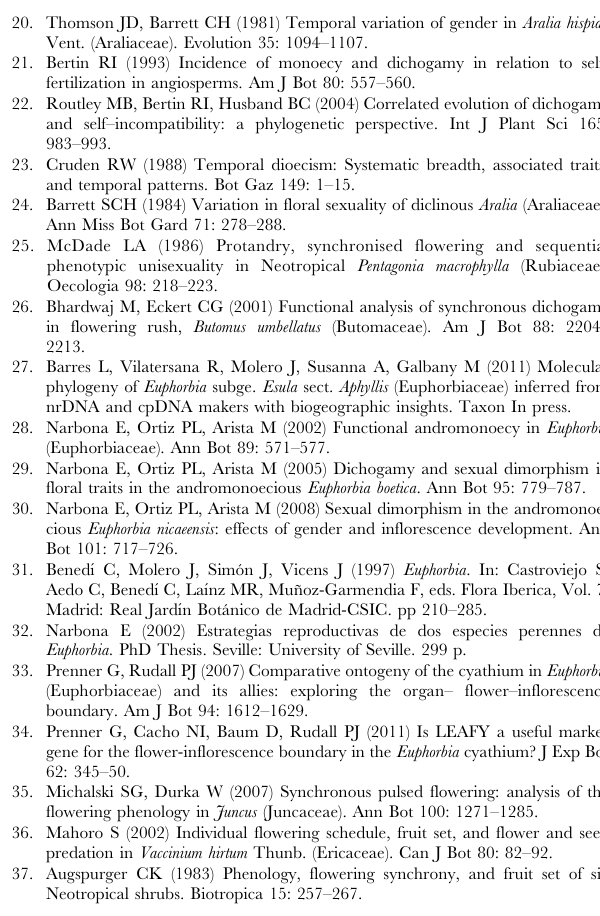
Figure S2 Frequency histograms showing in which inflorescence levels the overlapping between two inflo- rescence levels occurs in two populations over two years in E. boetica. Total number of censuses is shown in Table 2. (TIF) Figure S3 Pollen germination in stigmas of E. boetica and E. nicaeensis . Styles were fixed 24 h after pollination and stained with aniline blue. A, pollen germination after geitonoga- mous crosses in E. boetica ( 6 2500). B, pollen germination after xenogamous crosses in E. boetica ( 6 2500). C, pollen germination after geitonogamous crosses in E. nicaeensis ( 6 1600). D, pollen germination after xenogamous crosses in E. nicaeensis ( 6 1600). Bar = 5 m m. Yellow arrows show fluorescent accumulations of callose on stigma cells around the pollen tube penetration.